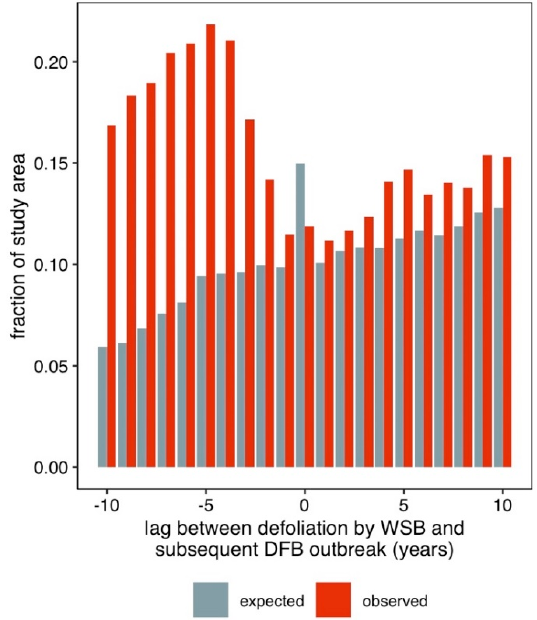
Figure A5. The observed and expected proportion of pixels affected by DFB and WSB by temporal lag for only pixels where the USFS Aerial Detection Surveys listed the severity of DFB-attributed tree mortality as low-moderate and WSB-attributed defoliation severity as high. Presence is defined as at least 25% (a four or more 240 × 240 m subpixel) listed presence of the agent and host. Here, − 5 signifies that WSB defoliation occurred 5 years prior to DFB presence. Red bars that exceed the height of grey bars indicate that spatiotemporal overlap of the two biotic agents occurs more often than expected due to chance at a given